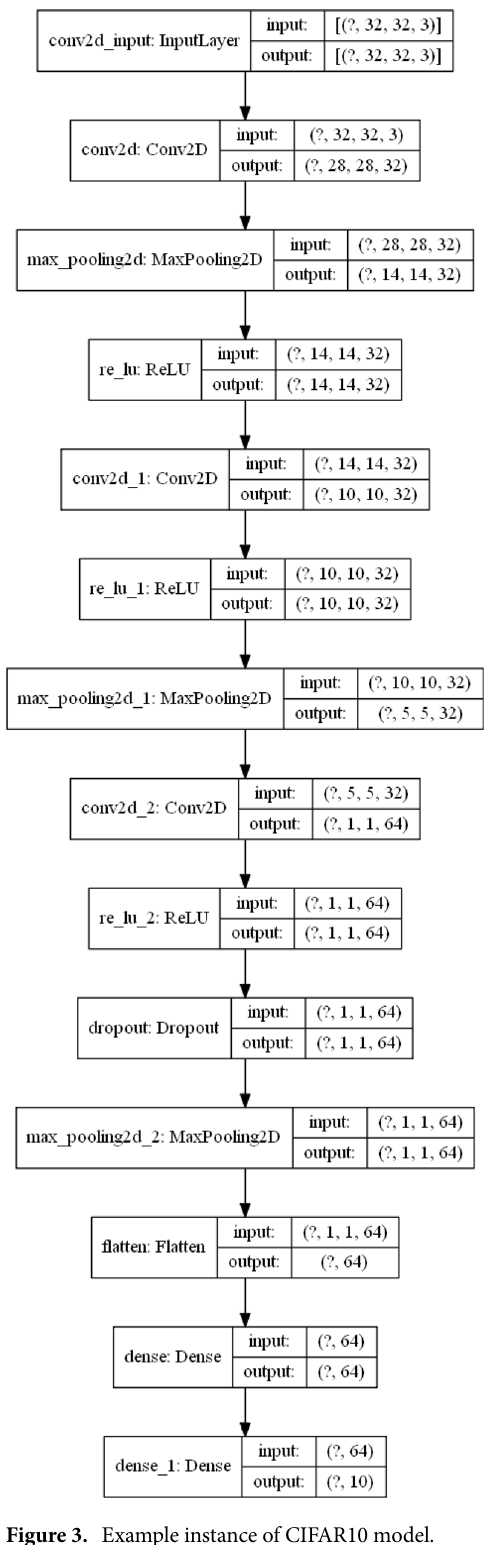
Figure 3. Example instance of CIFAR10